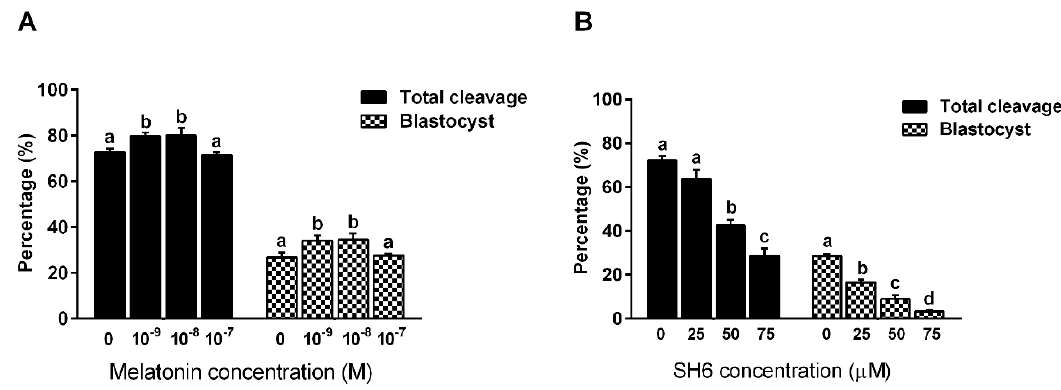
Figure 1. The effect of melatonin and SH6 on the developmental competence of bovine oocytes. Melatonin was added to the maturation medium at concentrations ranging from 10 − 9 , 10 − 8 and 10 − 7 M whereas SH6 was used at 25, 50 and 75 µM. ( A ) Total cleavage and day-8 blastocyst rates for serial dilution melatonin experiments; ( B ) Total cleavage and day-8 blastocyst for serial dilution SH6 experiments. Data are expressed as mean ± standard error of the mean (SEM). Values with different superscripts indicate statistically significant difference ( p < 0.05).